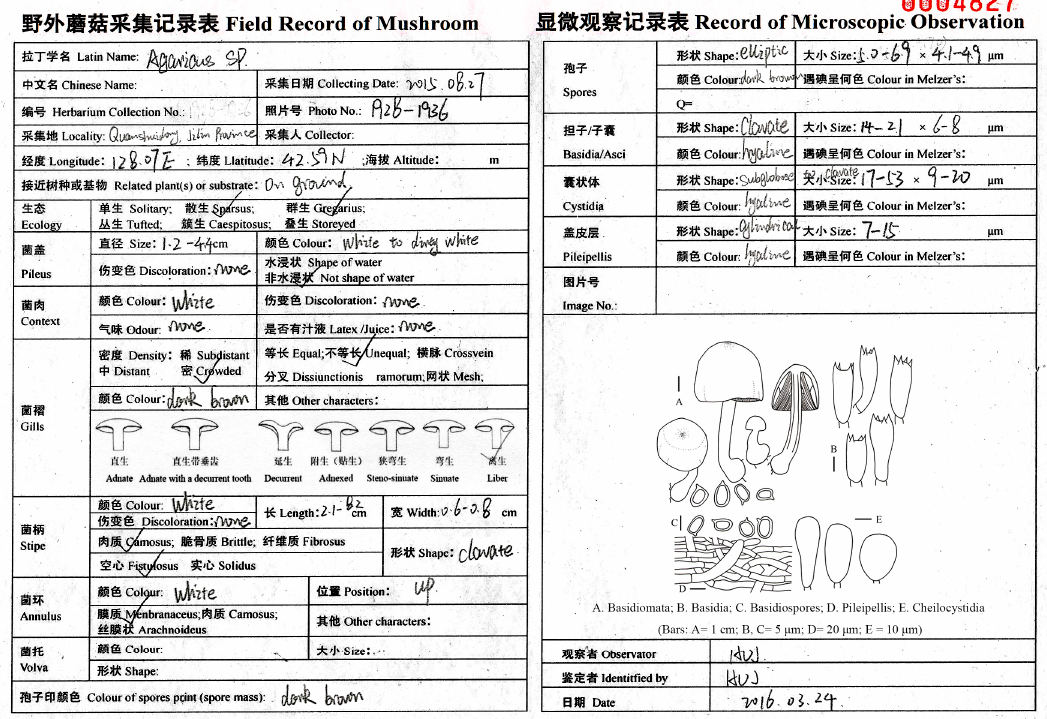
Figure 3. An example of field record and microscopic observation record of the collected